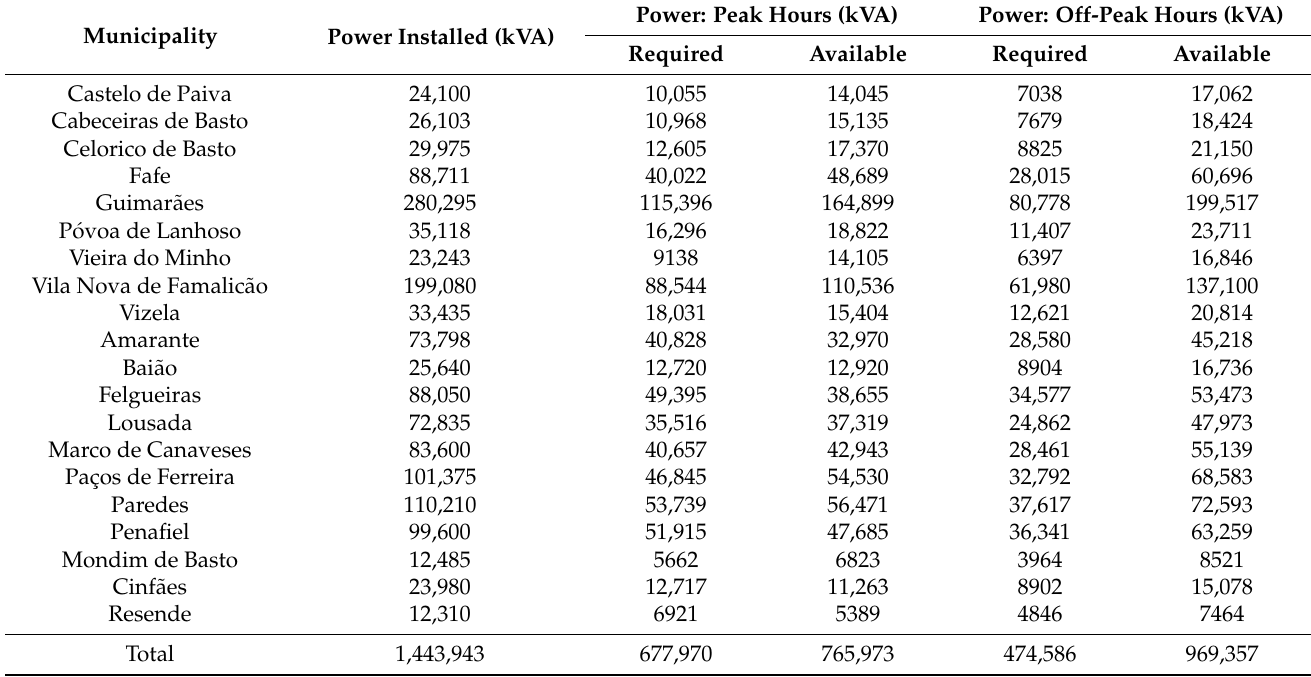
Table A1. Installed power and available energy during peak and off-peak hours by municipality [56]. Power: Peak Hours (kVA) Power: Off-Peak Hours (kVA) Municipality Power Installed (kVA) Required Available